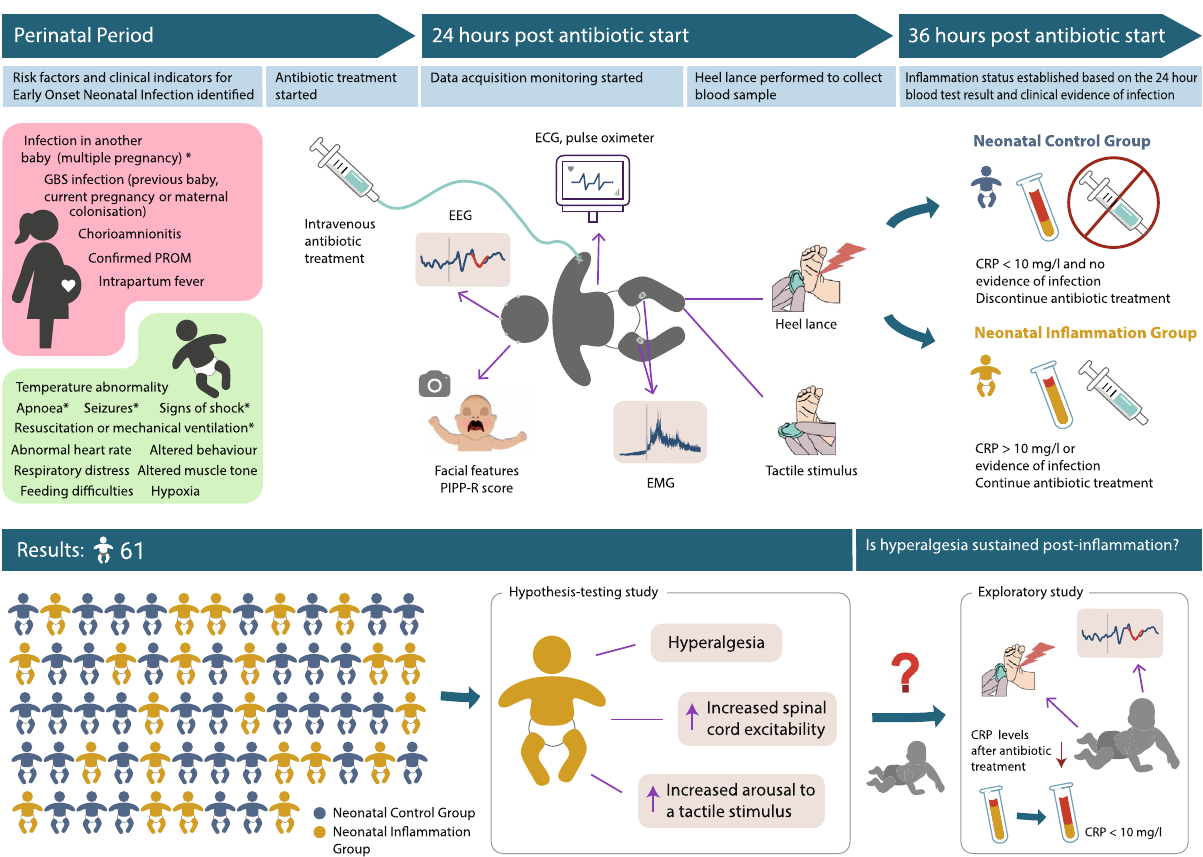
Fig. 1 Study design and main results. *Red fl ag risk factors and clinical indicators for Early-Onset Neonatal Infection (EONI). Antibiotic treatment was started if any red fl ag or two or more non-red- fl ag risk factors or clinical indicators were identi fi ed. See ref. 18 for the complete National Institute for Health and Care Excellence (NICE) EONI screening guidelines in place during the study period. GBS Group B Streptococcus , PROM premature rupture of membranes, EEG electroencephalography, PIPP-R premature infant pain pro fi le-revised, EMG electromyography, ECG electrocardiogram, CRP C-reactive